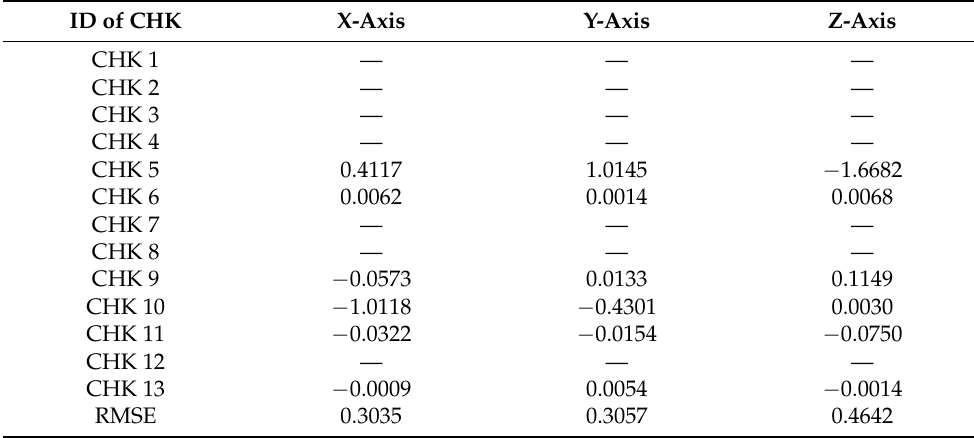
Table 3. Statistical Values for CHKS after the Second Experiment (Unit: meter).